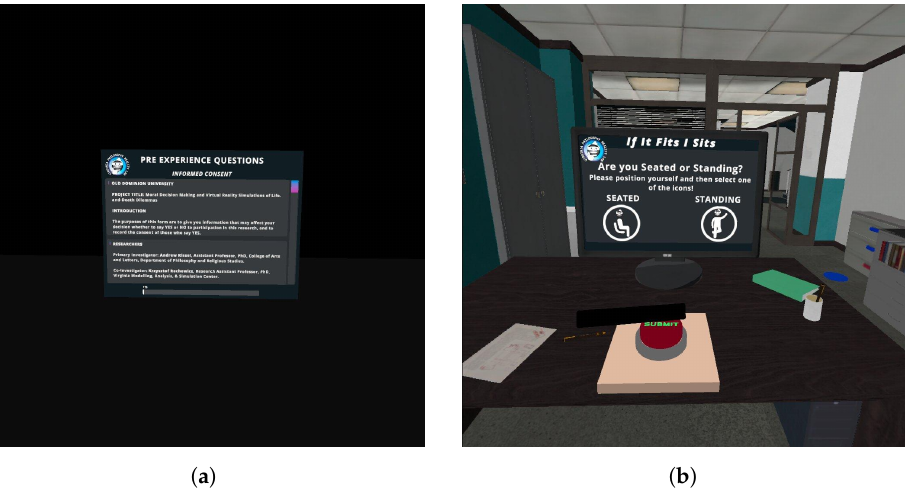
Figure 1. The onboarding process. ( a ) Informed consent forms and demographic questionnaires are completed before users are placed in a defined location. ( b ) Users learn navigation inside a small office and make accessibility